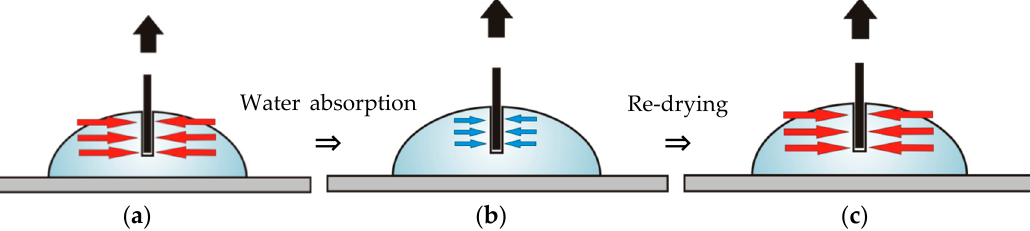
Figure 10. Schematic drawings of residual stress that varied by water absorption and re-drying in: ( a )